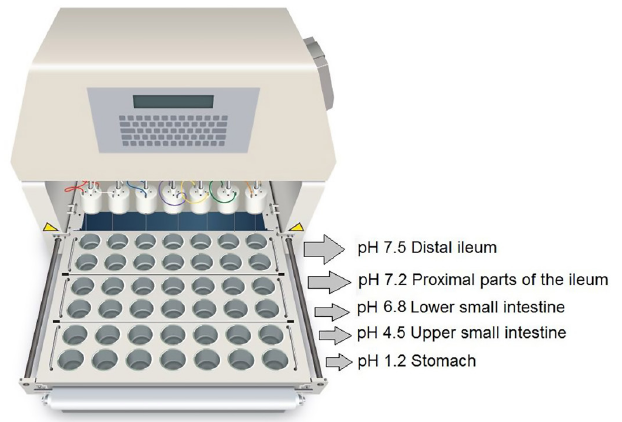
FIGURE 2 - Schematic representation of apparatus 3 and its six lines of vessels, each containing a dissolution medium with a different pH value, by way of example, simulating the passage of the product through the gastrointestinal (GI) tract (Borst, Ugwu, Beckett,